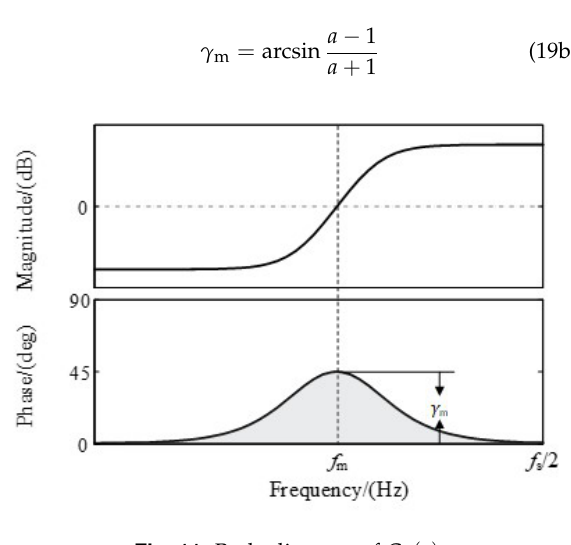
Fig. 11. Bode diagram of G 1 ( s ) .